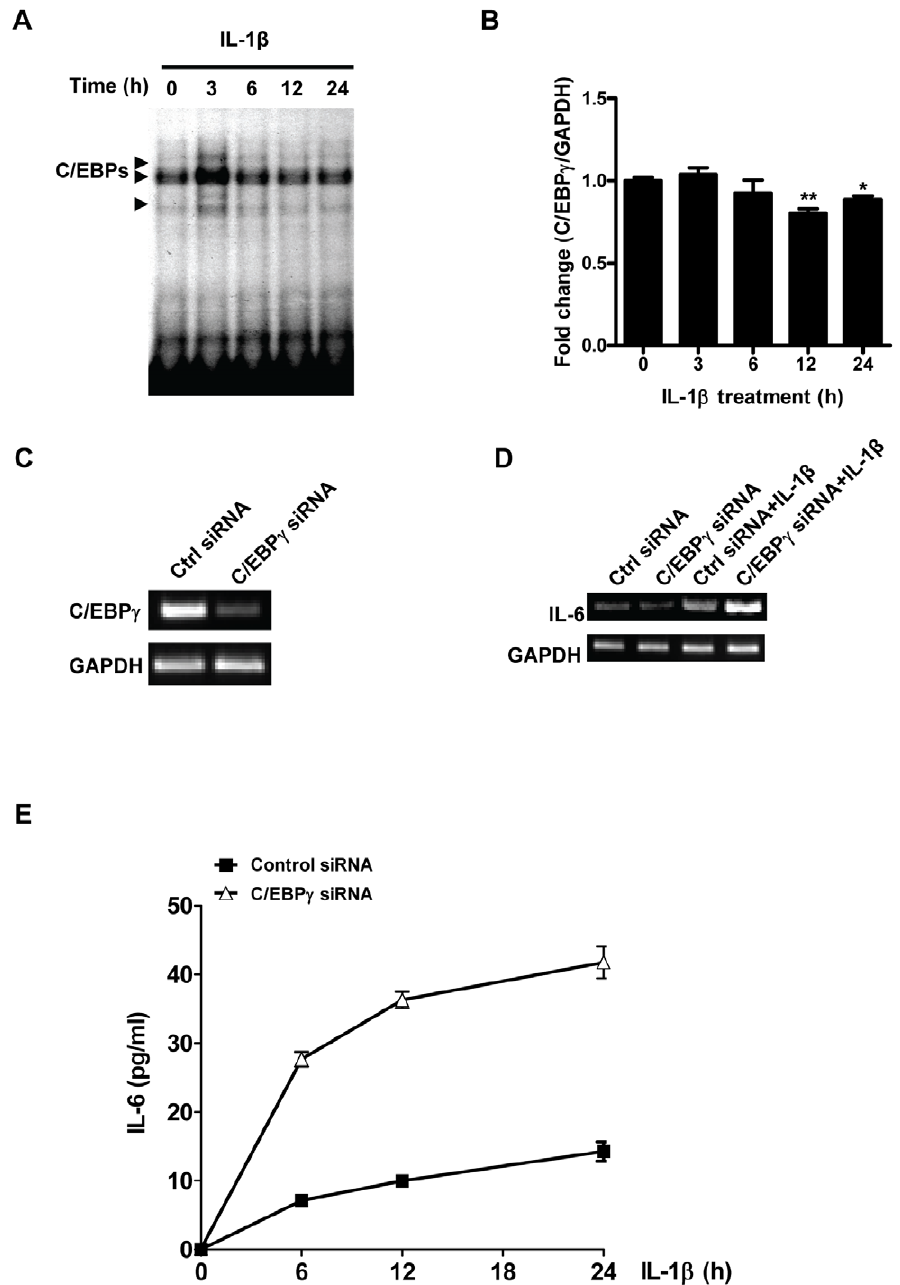
Figure 1. Knockdown of C/EBP c enhances IL-6 production in MLE12 cells. MLE12 cells were treated with 20 ng/ml IL-1 b for different time periods. A, the nuclear proteins were harvested. Activation of C/EBPs was detected by EMSA. B, total cellular RNA was extracted for Real time-PCR with primers for C/EBP c and GAPDH, respectively. C, the cells were transiently transfected with control siRNA, and C/EBP c -specific siRNA, respectively. 24 h after transfection, RNAs were isolated and RT-PCR was performed by using primers for C/EBP c , and GAPDH, respectively. D and E, MLE12 cells were transiently transfected with control siRNA or C/EBP c -specific siRNA. 24 h later, cells were stimulated by 20 ng/ml IL-1 b for indicated time periods. D, RNAs were harvested for RT-PCR using primers for IL-6, and GAPDH, respectively. E, the supernatants were harvested for ELISA. Data